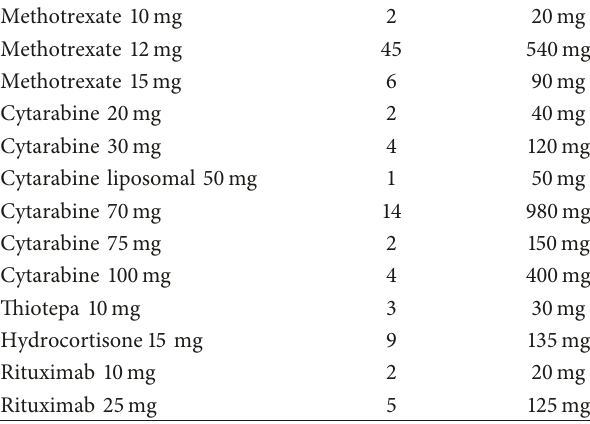
Table 1: Chemotherapy number of IT treatments total dose